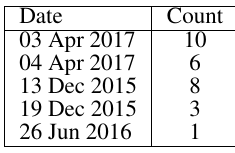
Table 1. Images used in the landslide segmentation task.